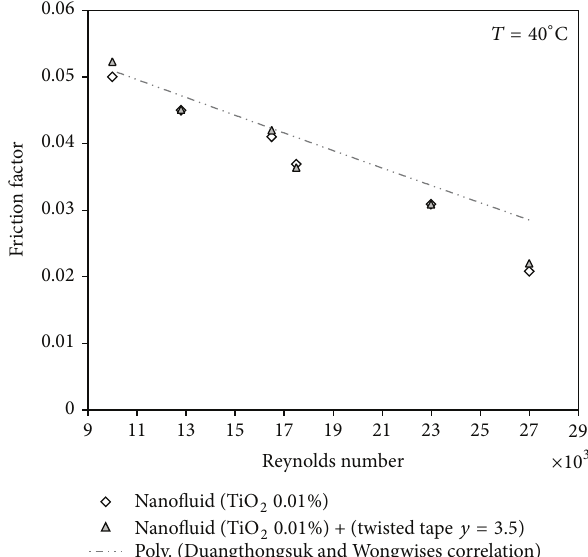
Figure 11: The effect of volume concentration and twisted-tape TiO 2 -water on the pressure drop at different Reynolds numbers.